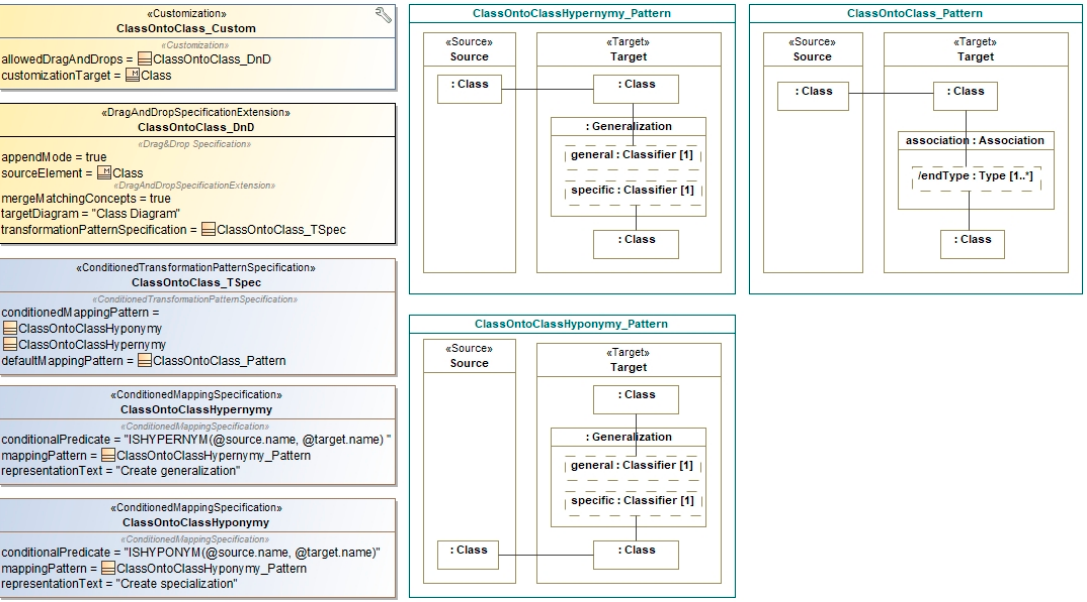
Figure 11. M2M transformation specification example incorporating semantic relationship processing.